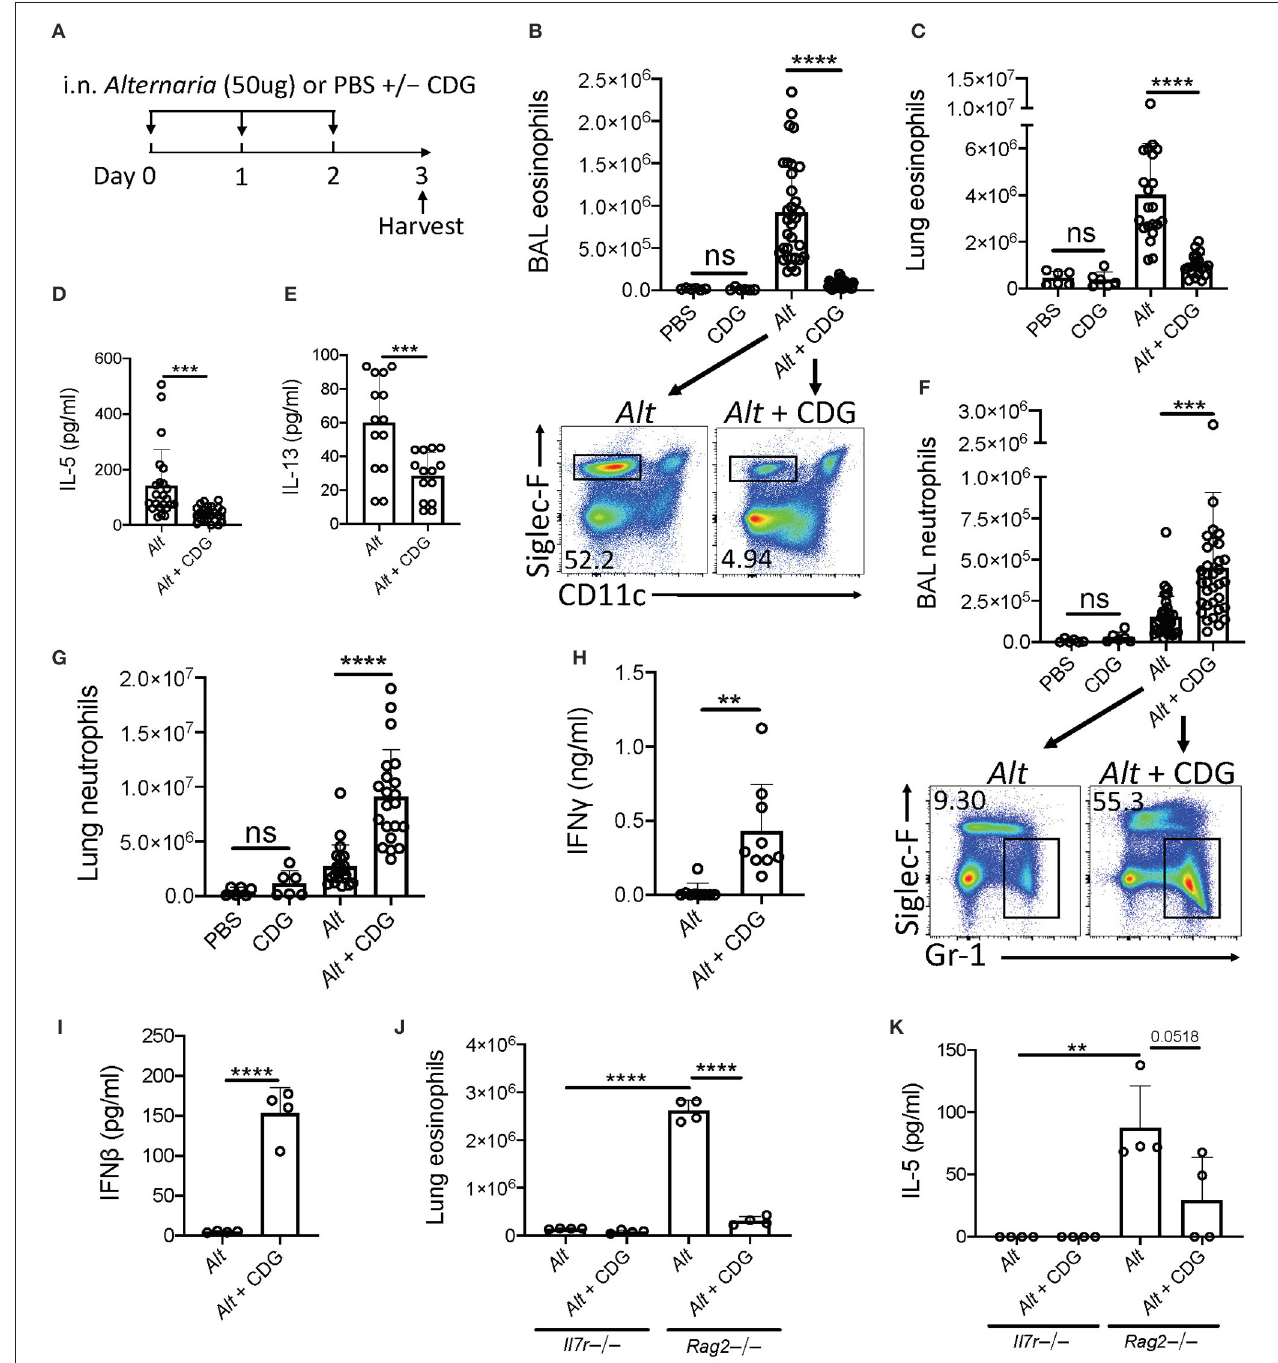
FIGURE 1 | CDG abrogates Alt -induced type 2 inflammation and promotes neutrophilia. (A) Intranasal challenge mouse model of innate airway inflammation. (B) Total BAL eosinophils (top) and representative flow plots (bottom). (C) Total lung eosinophils. BAL IL-5 (D) and IL-13 (E) ELISA. (F) Total BAL neutrophils (top) and representative flow plots (bottom). (G) Total lug neutrophils. (H) BAL IFN γ ELISA. (I) BAL IFN β ELISA 3h after first challenge. Il7r -/- and Rag2 -/- lung eosinophils (J) and BAL IL-5 ELISA (K) . Data shown are representative of 2–10 independent experiments with 2–4 mice per group. ** P < 0.01, *** P < 0.001, **** P < 0.0001, unpaired t